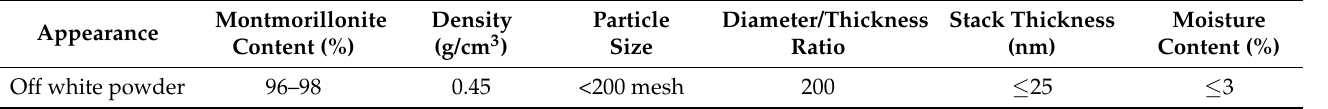
Table 1. Main technical indicators of Nano-clay.